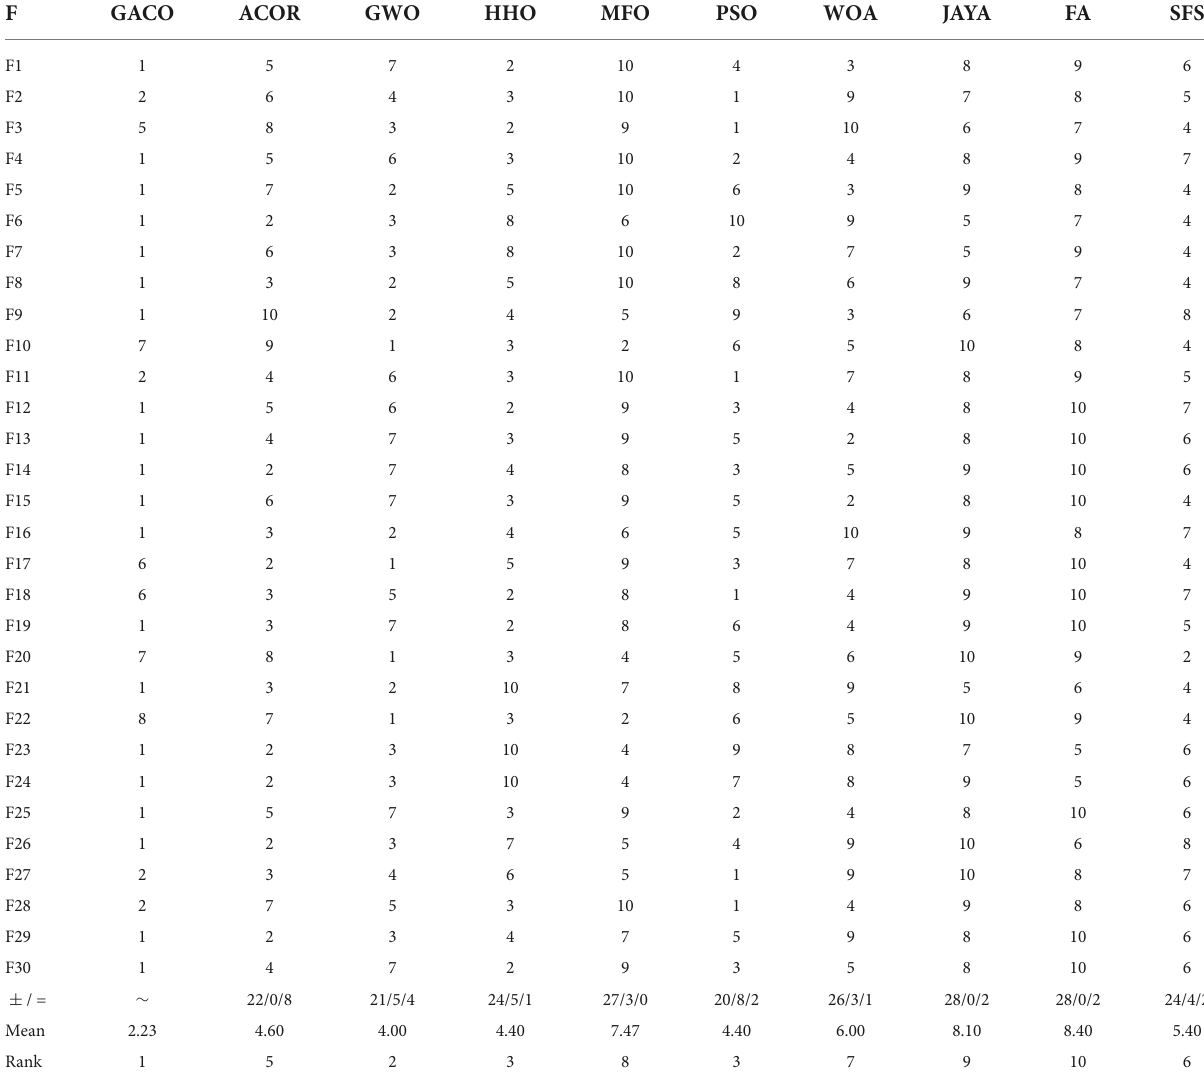
TABLE 7 The performance ranking of all algorithms and the results of the Wilcoxon signed-rank test. F GACO ACOR GWO